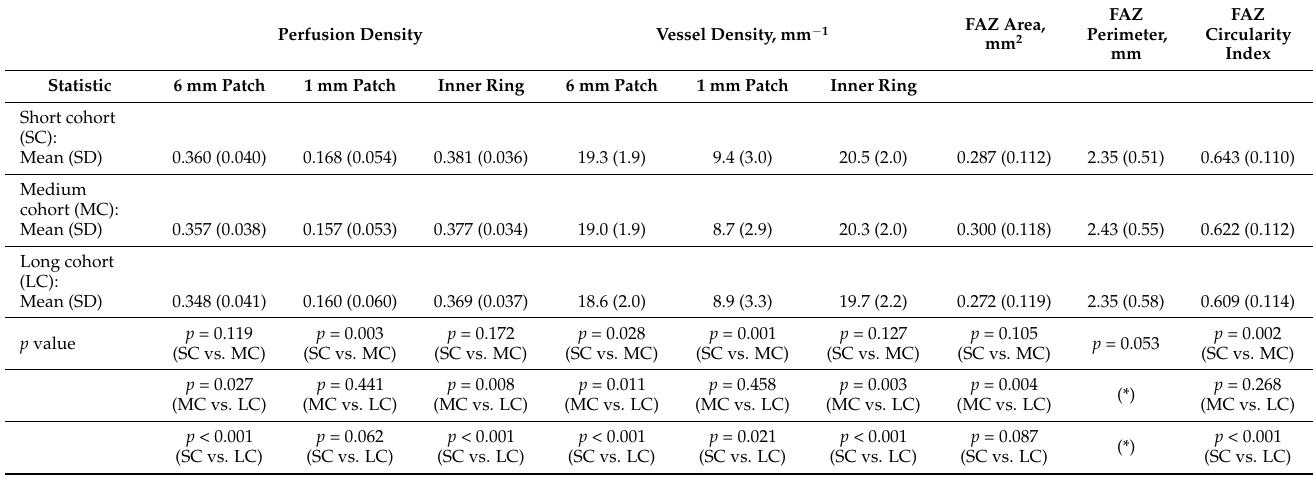
Table 2. Descriptive Statistics for Density Metrics and Foveal Avascular Zone (FAZ) Area in the Superficial Capillary Plexus (SCP) for the Three Diabetes Duration Groups.